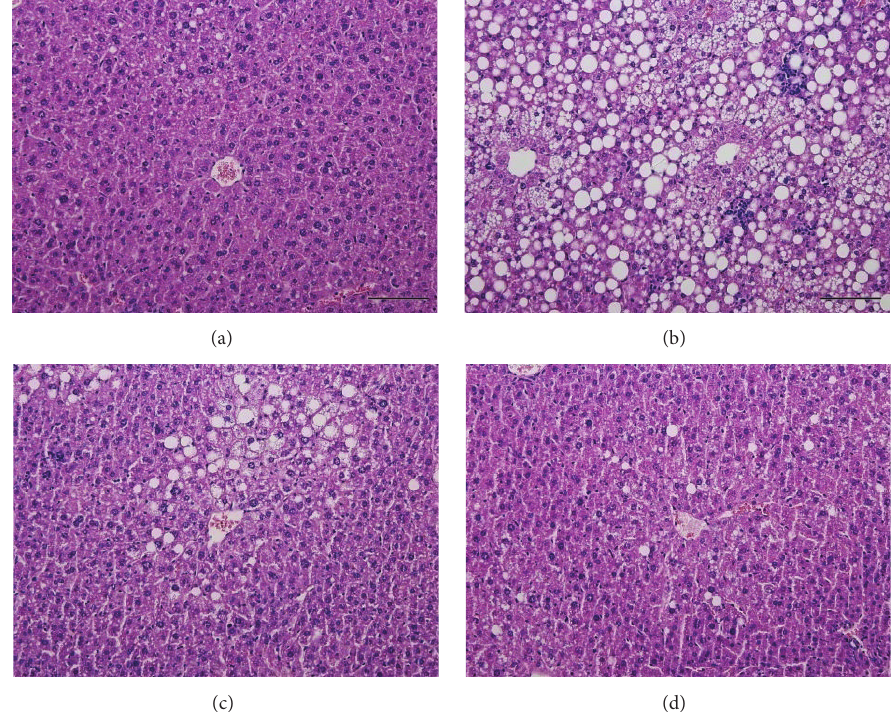
Figure 8: H&E staining of liver tissue. (a) Normal control; (b) HFD (60% fat calorie diet group); (c) HFD + Orlistat treated (40mg/kg); (d) HFD + 1.3g/kg UP601 treated. Magnification is × 200 and the bar means 100 𝜇